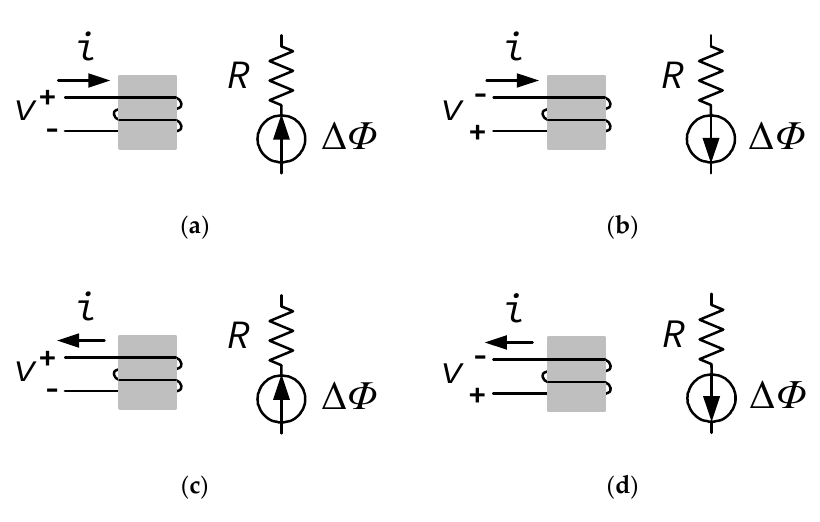
Figure 7. Definition of AC magnetic flux models.